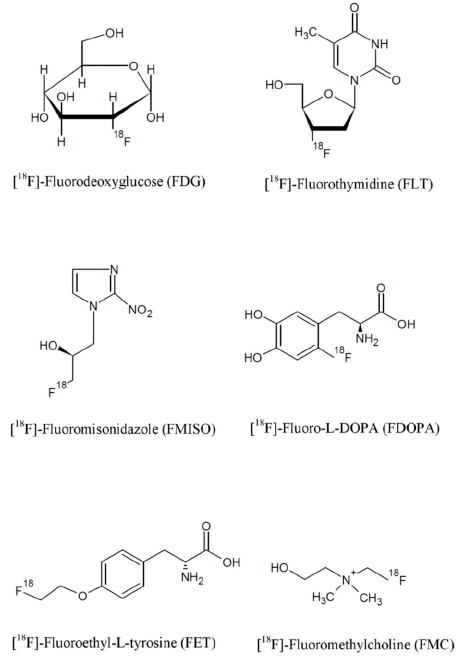
Figure 2. Chemical structure of fluorine-based radiopharmaceuticals .